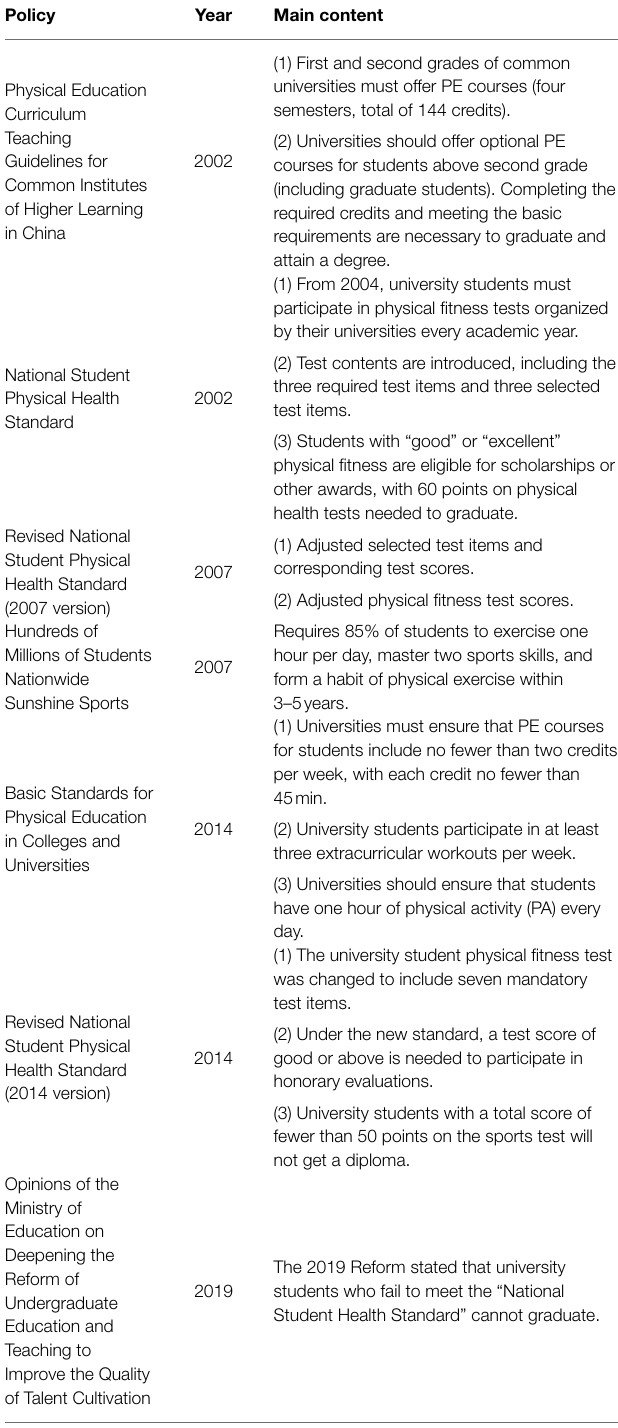
TABLE 1 | Physical education (PE) policies issued by the Chinese government since 2002 for university